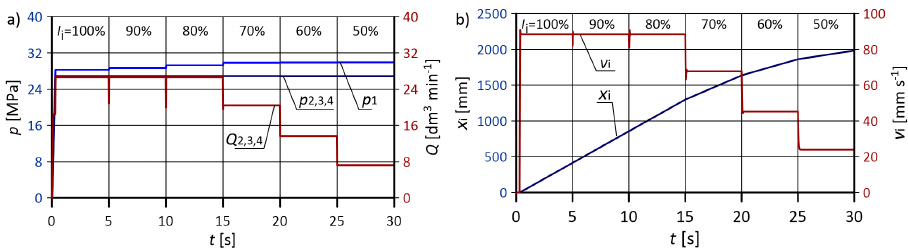
Figure 8. Results of the base system, equal load force F load , i = 135 kN; ( a ) pressures and flow rates, ( b ) speeds and positions of